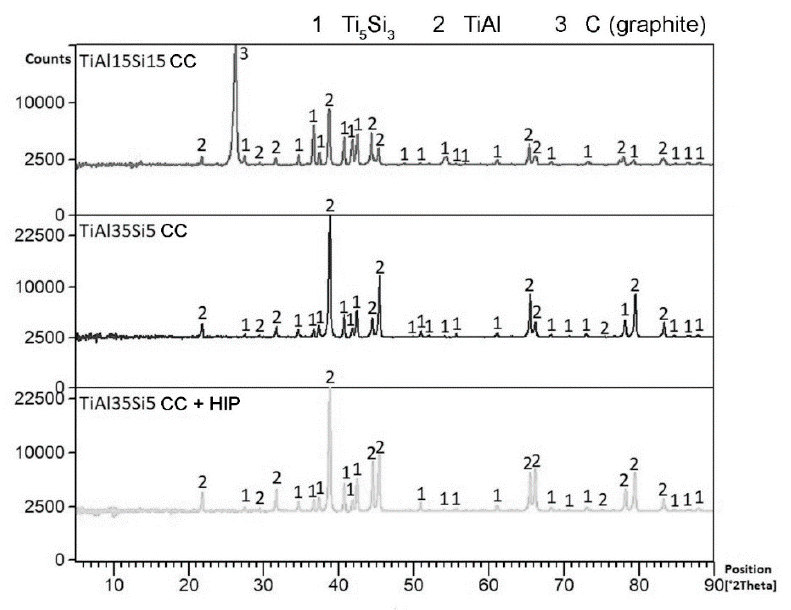
Figure 1. XRD patterns of the tested alloys.